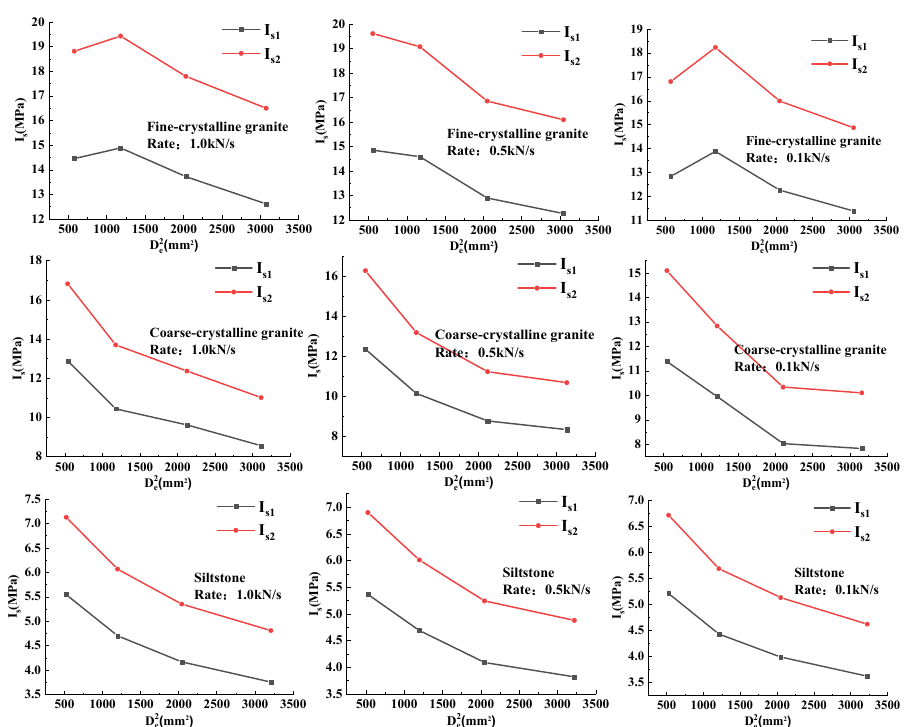
Figure 8. Relationship between two point load strength indexes I s and size for the three rock samples under different loading rates.